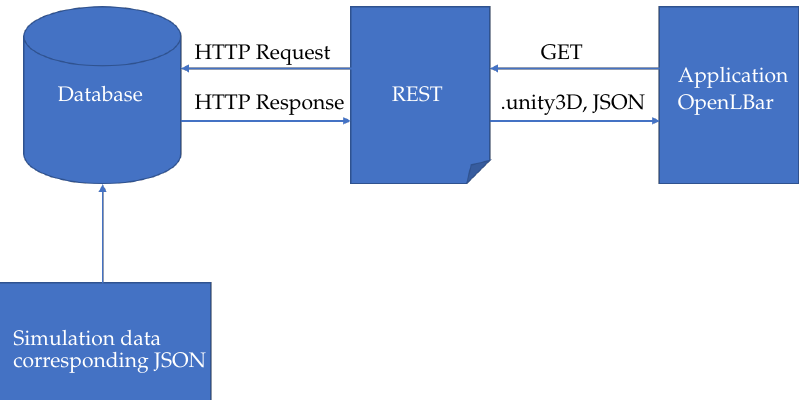
Figure 2. Schematic representation of the requests and dataflows used in OpenLBar using a REST interface.